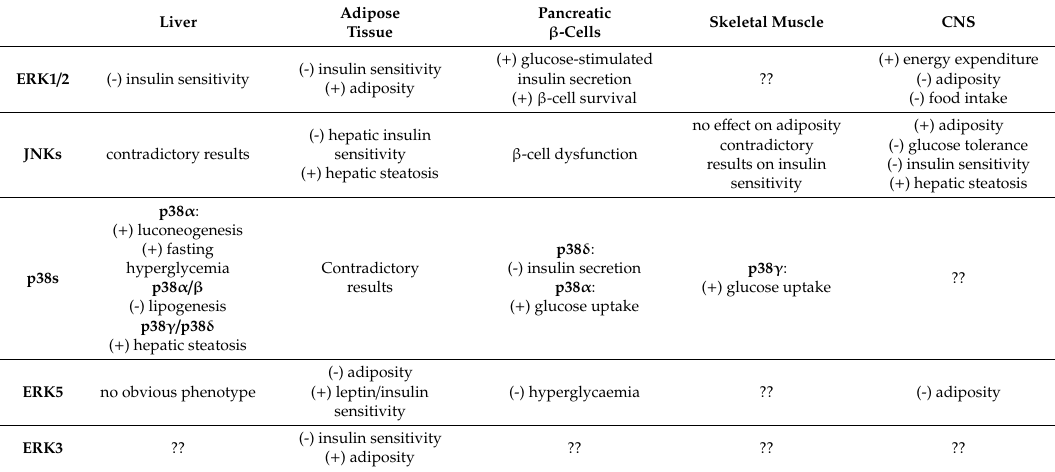
Table 2. MAPKs and metabolic phenotype observed in genetic in vivo experiments. (–) indicates negatively regulated. ( + ) indicates positively regulated. ?? indicates parameter was not